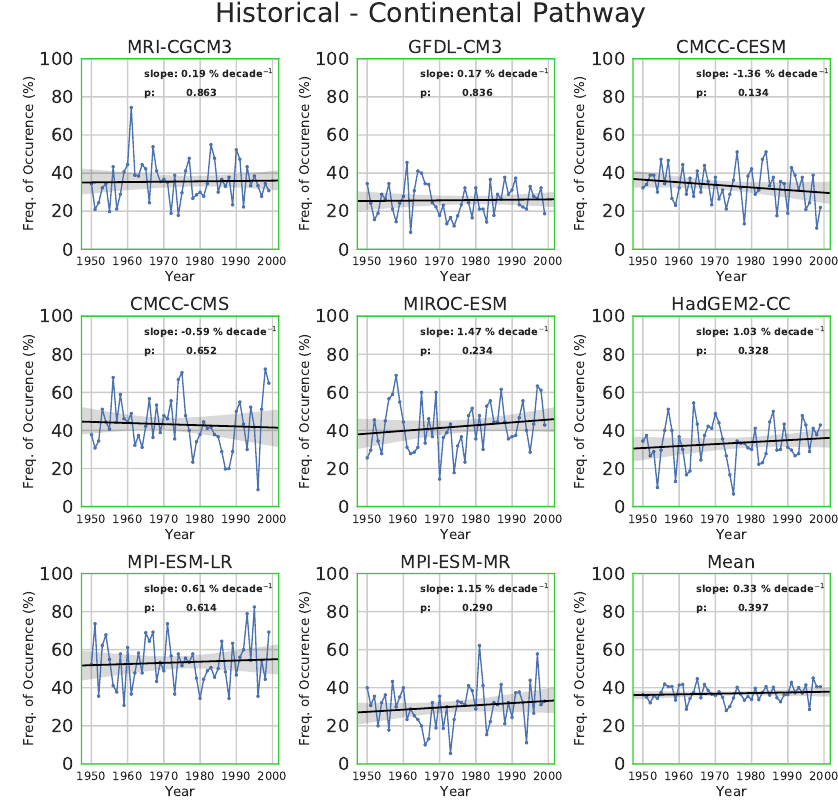
Figure 9. Same as in Figure8, but for the Continental pathway.